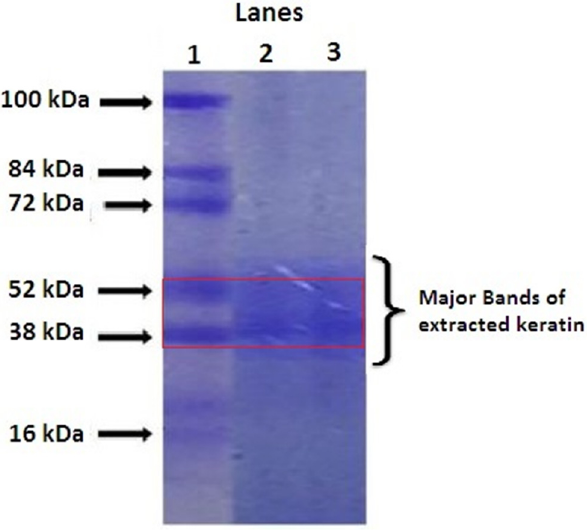
Figure 1. SDS PAGE analysis of keratin (Lane 1: Serum, Lane 2: Protein marker, Lane 3: Extracted keratin).